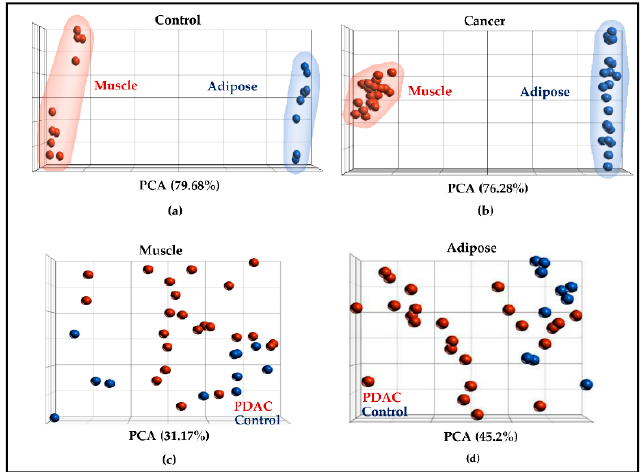
Figure 2. Principal component analysis. All the profiled genes were utilized for the analysis. ( a , b ) Indicate that gene expression gene signatures between muscle ( a ) and adipose ( b ) were indeed different in controls and PDAC; ( c , d ) illustrate the PCA within muscle ( c ) and adipose in controls and PDAC ( d